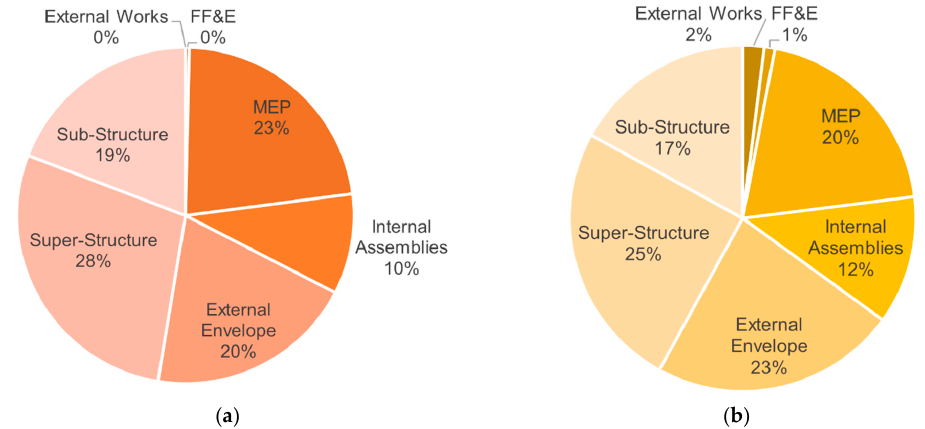
Figure 11. Each building assembly category shares in LCA (Portlands Place on the left and GLA benchmark on the right). ( a ) Portlands Place (total carbon footprint 1076 kgCO 2e /m²). ( b ) GLA.